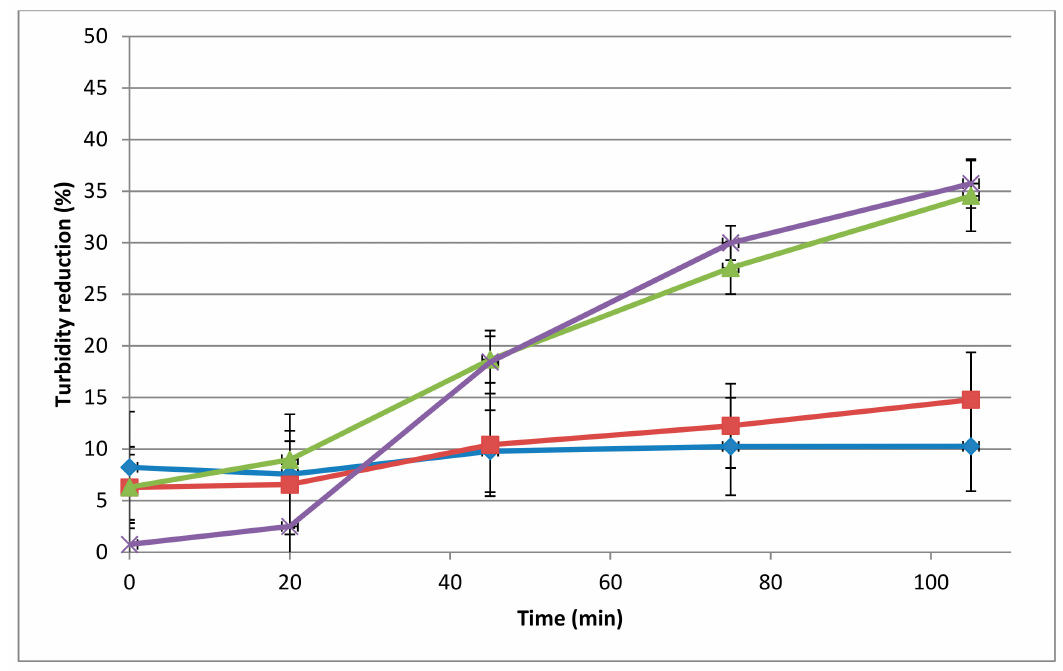
Figure 1. Dose-dependent muralytic activity of the 293-amidase against autoclaved L. monocytogenes 473 cells. Lytic activity (assays in microtiter plates) is represented as the percentage of turbidity reduction operated by the 293-amidase at di ff erent concentrations. Di ff erent colours are di ff erent concentrations: blue, 10 µ g / mL; red, 20 µ g / mL; green, 40 µ g / mL; purple, 75 µ g / mL. Each data point is the average of triplicates and the standard deviations are indicated as error